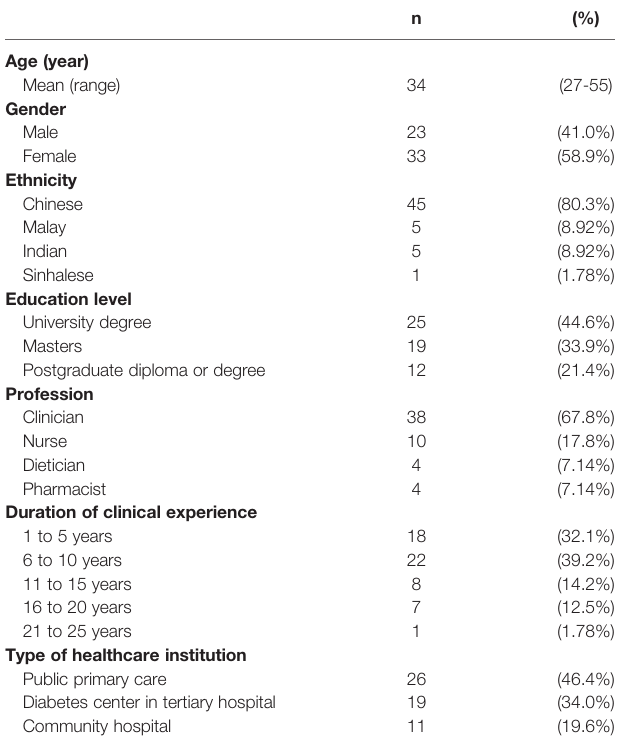
TABLE 1 | Participant characteristics (n =